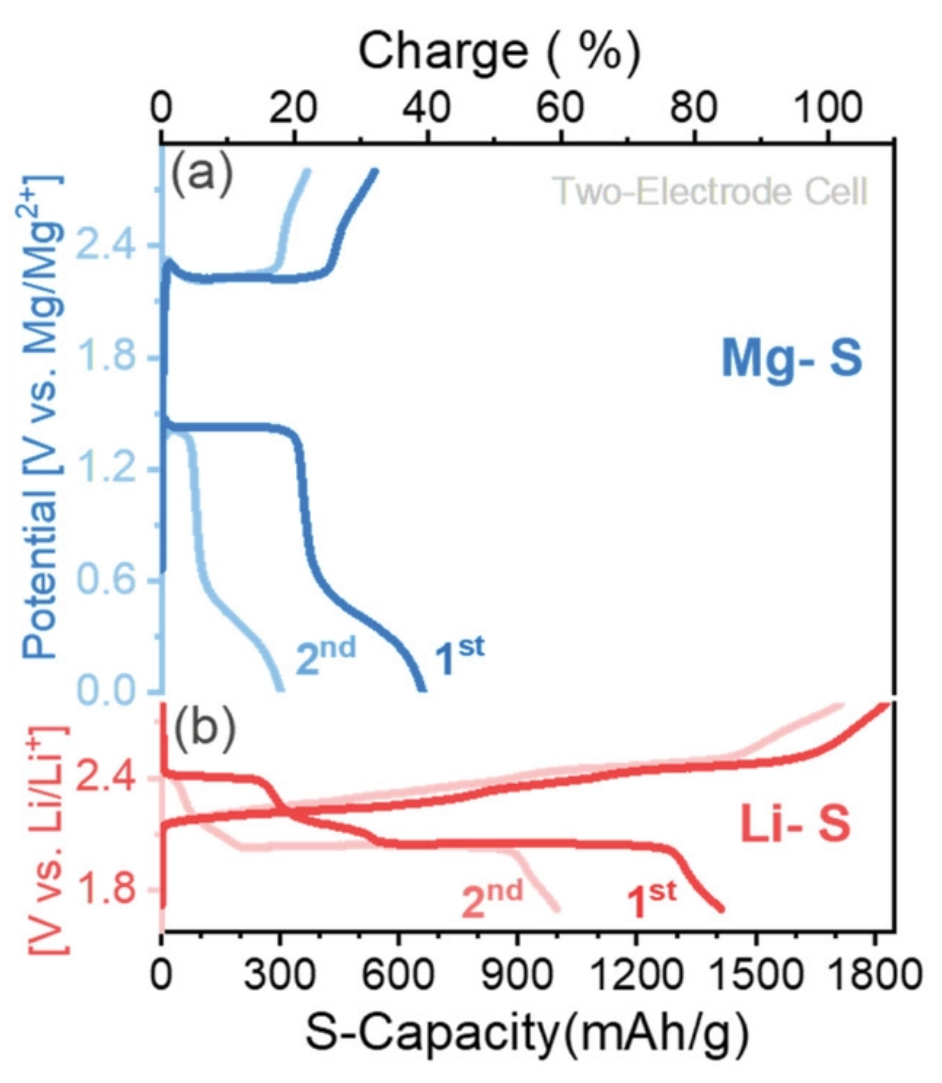
Figure 4. Galvanostatic discharge/charge profile of Mg–S and Li–S two-electrode cells with a respective electrolyte: ( a ) 0.5 m Mg(TFSI)2 in DME; ( b ) LiTFSI in DME; operating under the load of 0.1 C. Taken from [28].